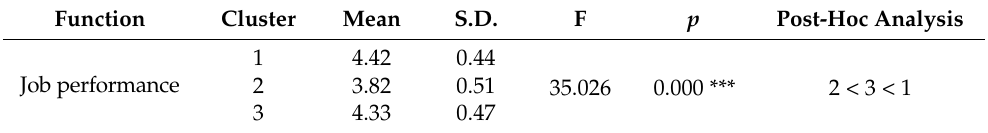
Table 8. Results of differences of job performance by cluster.